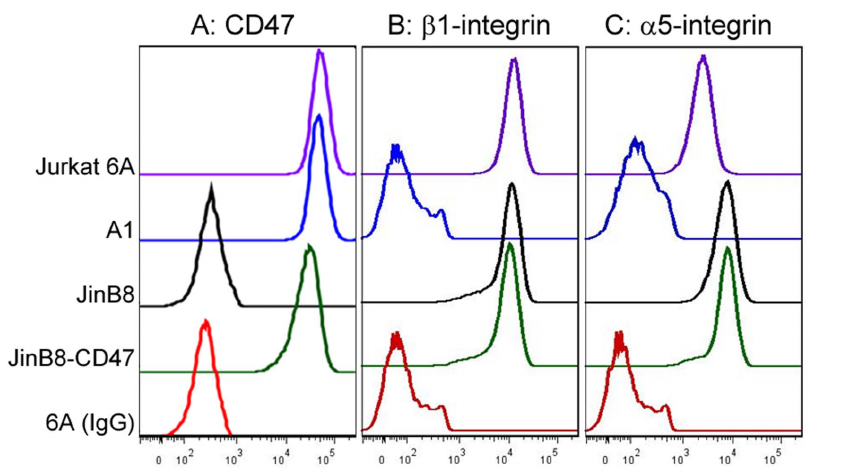
Figure 1. Expression of CD47, b 1-integrin and a 5-integrin receptors on various Jurkat cell lines used. 6A is the wildtype Jurkat T-cells and parental strain to A1, which is deficient in b 1-integrin expression. JinB8 is a CD47-deficient derivative of Jurkat cells, while JinB8-CD47 is stably reconstituted with expression of CD47 isoform 2. Cells were harvested, washed with PBS and incubated with the indicated primary antibodies. Following washes and incubation with fluorophore-conjugated secondary antibodies, bound antibodies was assessed by flow cytometry as an indicator of receptor expression levels. Normal mouse IgG was used as a non-specific primary antibody control.